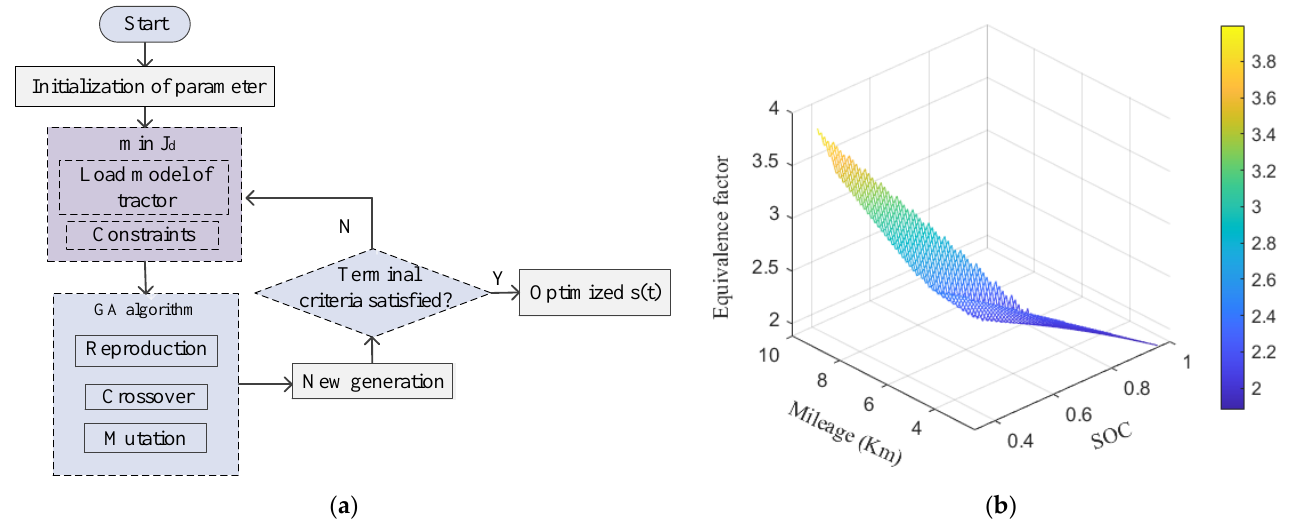
Figure 7. The optimized equivalence factor. ( a ) The process of GA optimization. ( b ) Equivalent factors under different SOC and rotary tillage mileages.